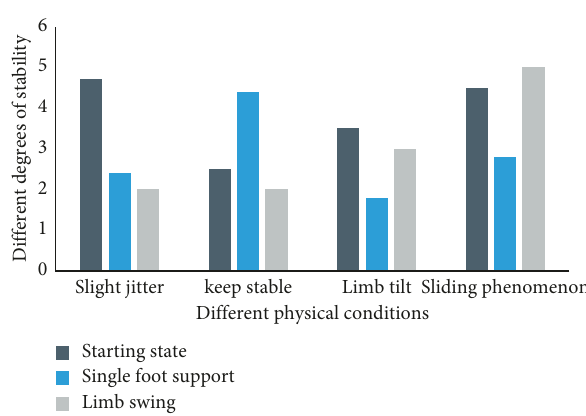
Figure 4: Simulation neural network control data for the walking mode of the biped robot.